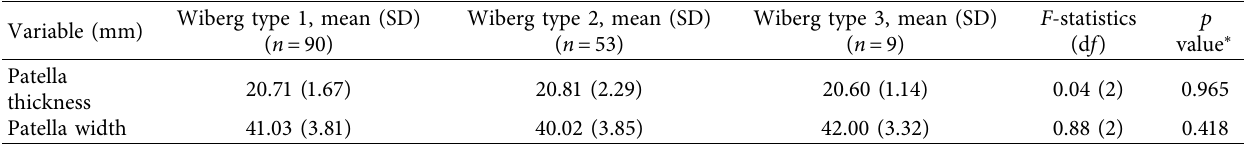
Table 3: Comparison of patella thickness and width with Wiberg type ( n �